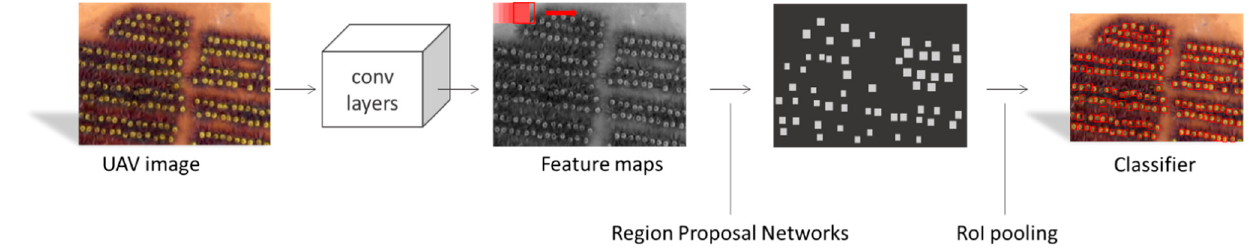
Figure 4. The framework of pineapple detection with Faster R-CNN.